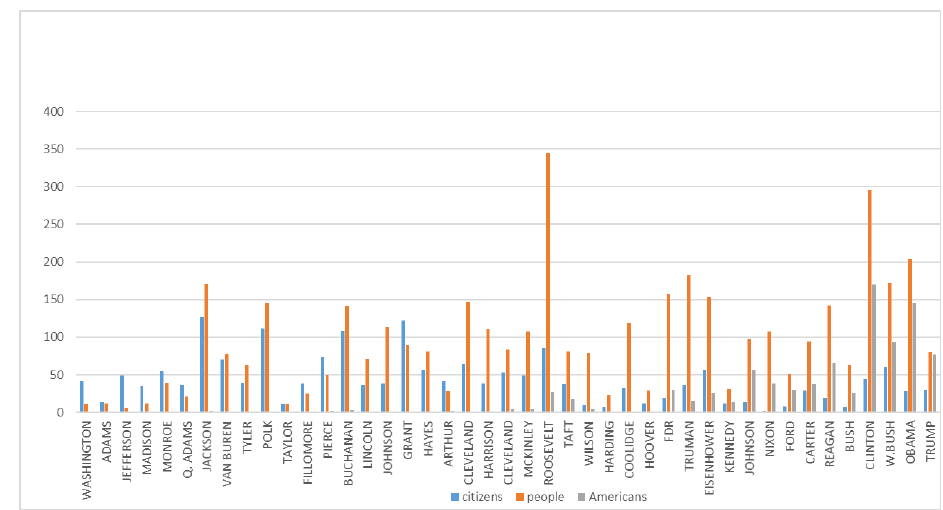
Figure 4. Absolute frequencies of citizens , people and Americans by president.